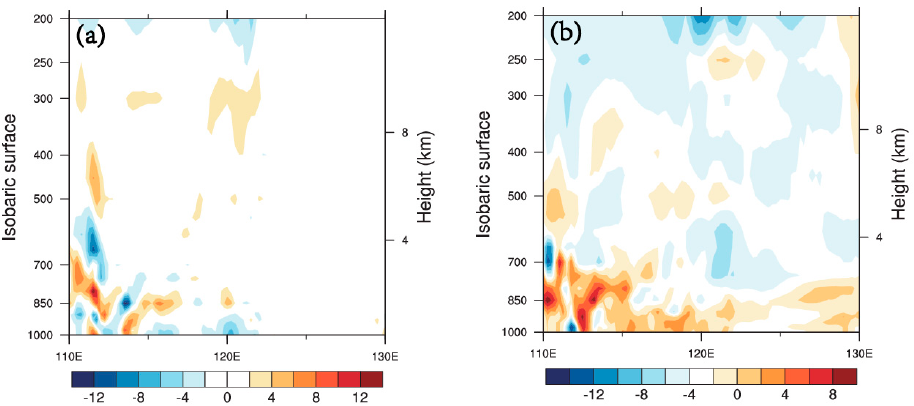
Figure 9. Longitude-vertical cross section of ( a ) divergence (10 − 5 s − 1 ) and ( b ) relative vorticity (10 − 5 s − 1 ) along 32°N at 0600 UTC 16 September 2018.